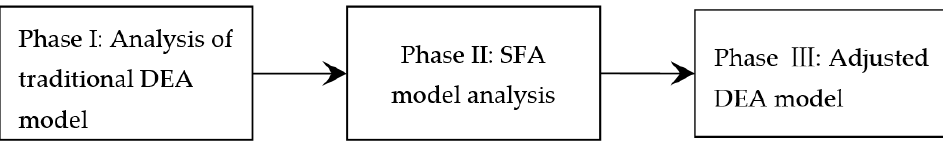
Figure 1. Flow chart of research methods.